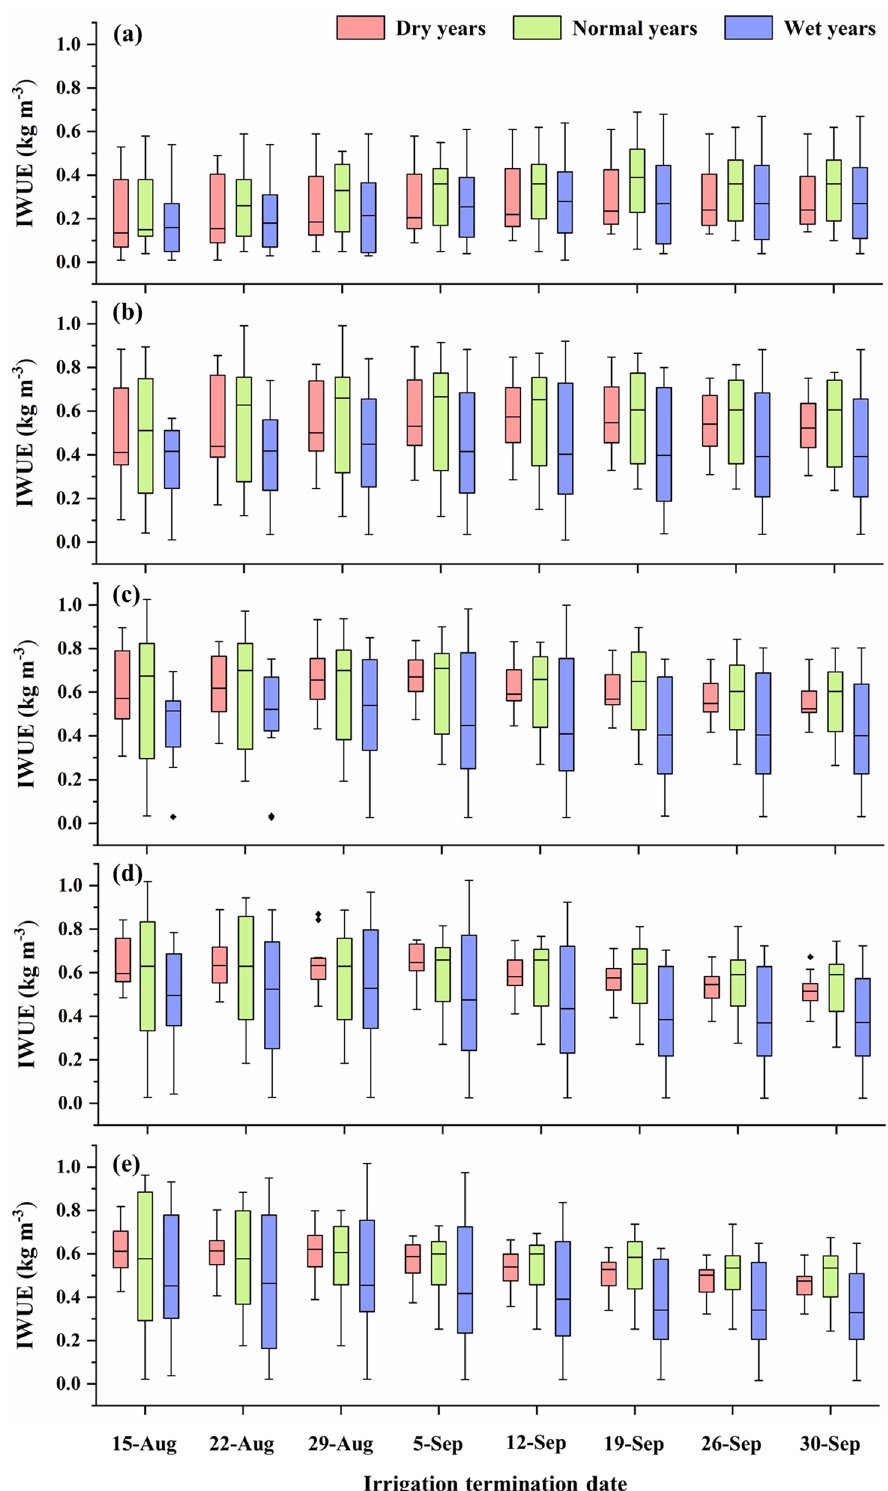
Figure 4. Effect of irrigation termination date on simulated irrigation water use efficiency (IWUE) under: ( a ) 55%, ( b ) 70%, ( c ) 85%, ( d ) 100% and ( e ) 115% ET-replacement strategies. The ends of the boxes indicate 25th and 75th percentiles, and the horizontal line inside the box indicates the